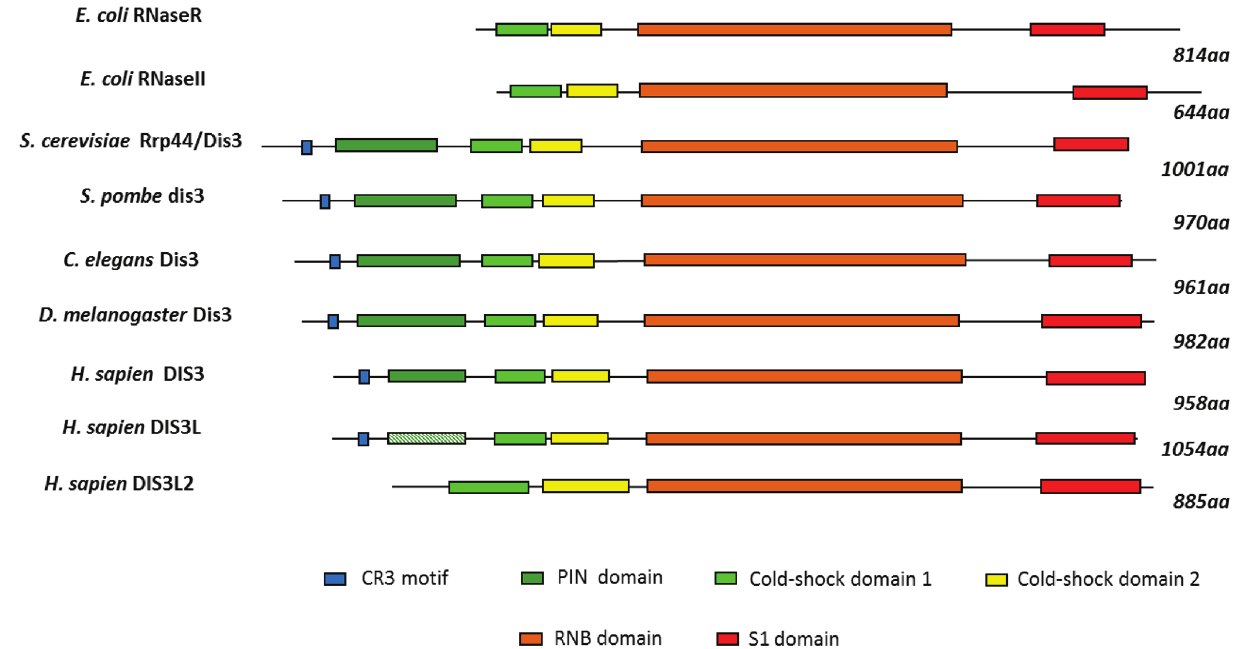
Figure 1. Domain organisation of members of the RNR/RNase II superfamily. Members of this family have a similar modular domain organization. The N-terminal region is variable but cold-shock domain 1 and cold-shock domain 2 are present in all members, followed by a RNB domain and an S1 domain. At the N-terminus, S. cerevisiae Rrp44/Dis3 and some other members also contain a conserved CR3 motif and a catalytic PIN domain. However, mutations in human DIS3L render the PIN domain inactive (hatched). Dis3L2 has lost the N-terminal extension but contains extended cold shock domains. See text for details of domain functions. See reference [31] for more detail on domain